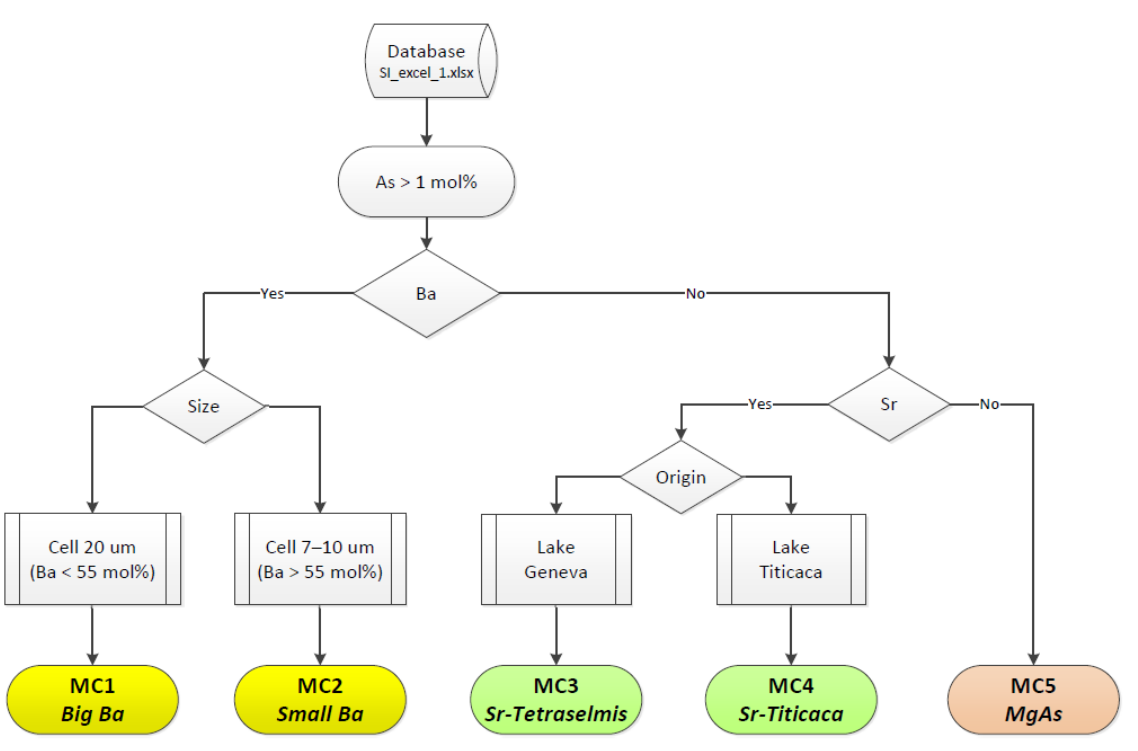
Figure 3. Procedure for the definition of five morpho-chemical groups among the As-bearing micropearls in Lakes Geneva and Titicaca. Table 1. Lab data: descriptive statistics of characteristic elements in the five morpho-chemical groups of As-containing micropearls in Lake Geneva (MC1, MC2, MC3 and MC5) and Lake Titicaca (MC4). Ns: number of samples. Nv: number of descriptors. SD: standard deviation. Grey: not taken